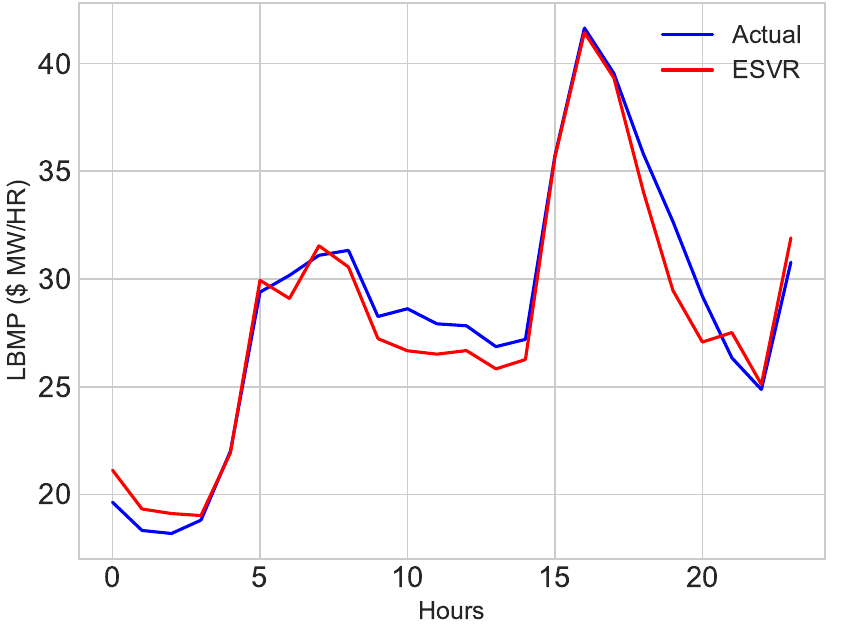
Figure 14. First Week of January,